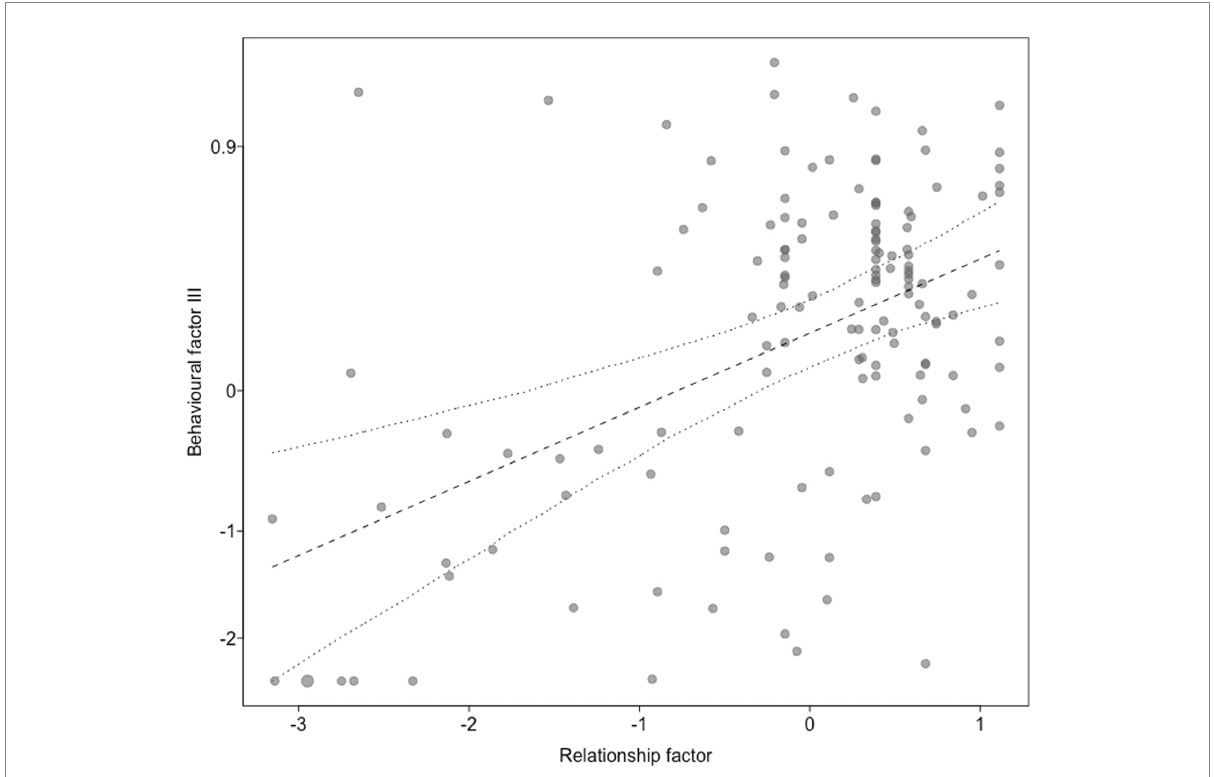
FIGURE 4 Behavioral factor III ( y -axis) as a function of the relationship factor ( x -axis). Dots show the individual data, the straight line represents the predictive mean of the model, and the dashed on dotted lines the fitted model and its 95% confidence limits with all other predictors centered to a mean of zero. Behavioral factor III was mainly correlated with proportion time petting and proportion time staying with